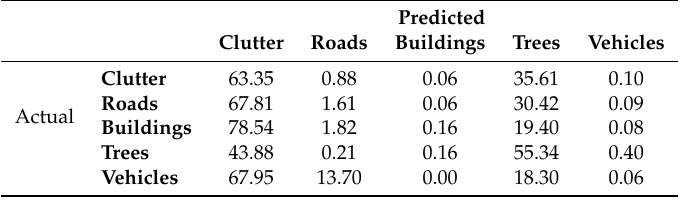
Table A15. Normalized confusion matrix for the GSCNN model that is trained on coordinates and colors, and uses class weights, after 400